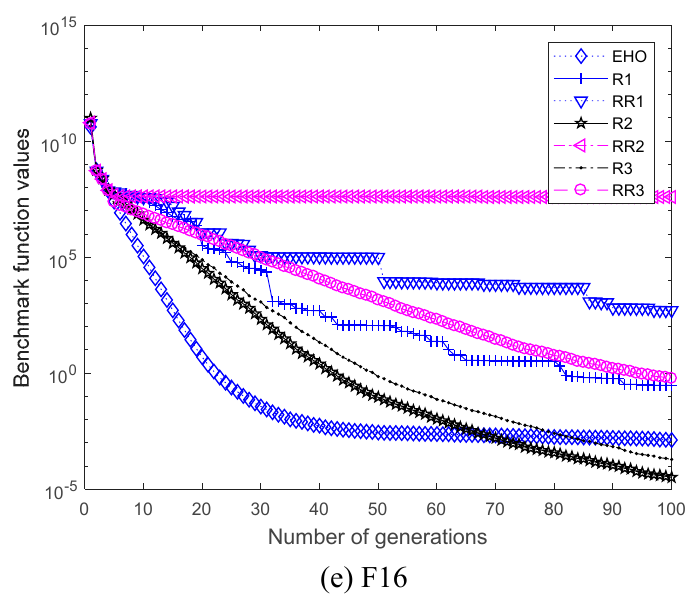
Figure 1. Optimization process of seven algorithms on five functions with D = 50. EHO—elephant herd optimization.